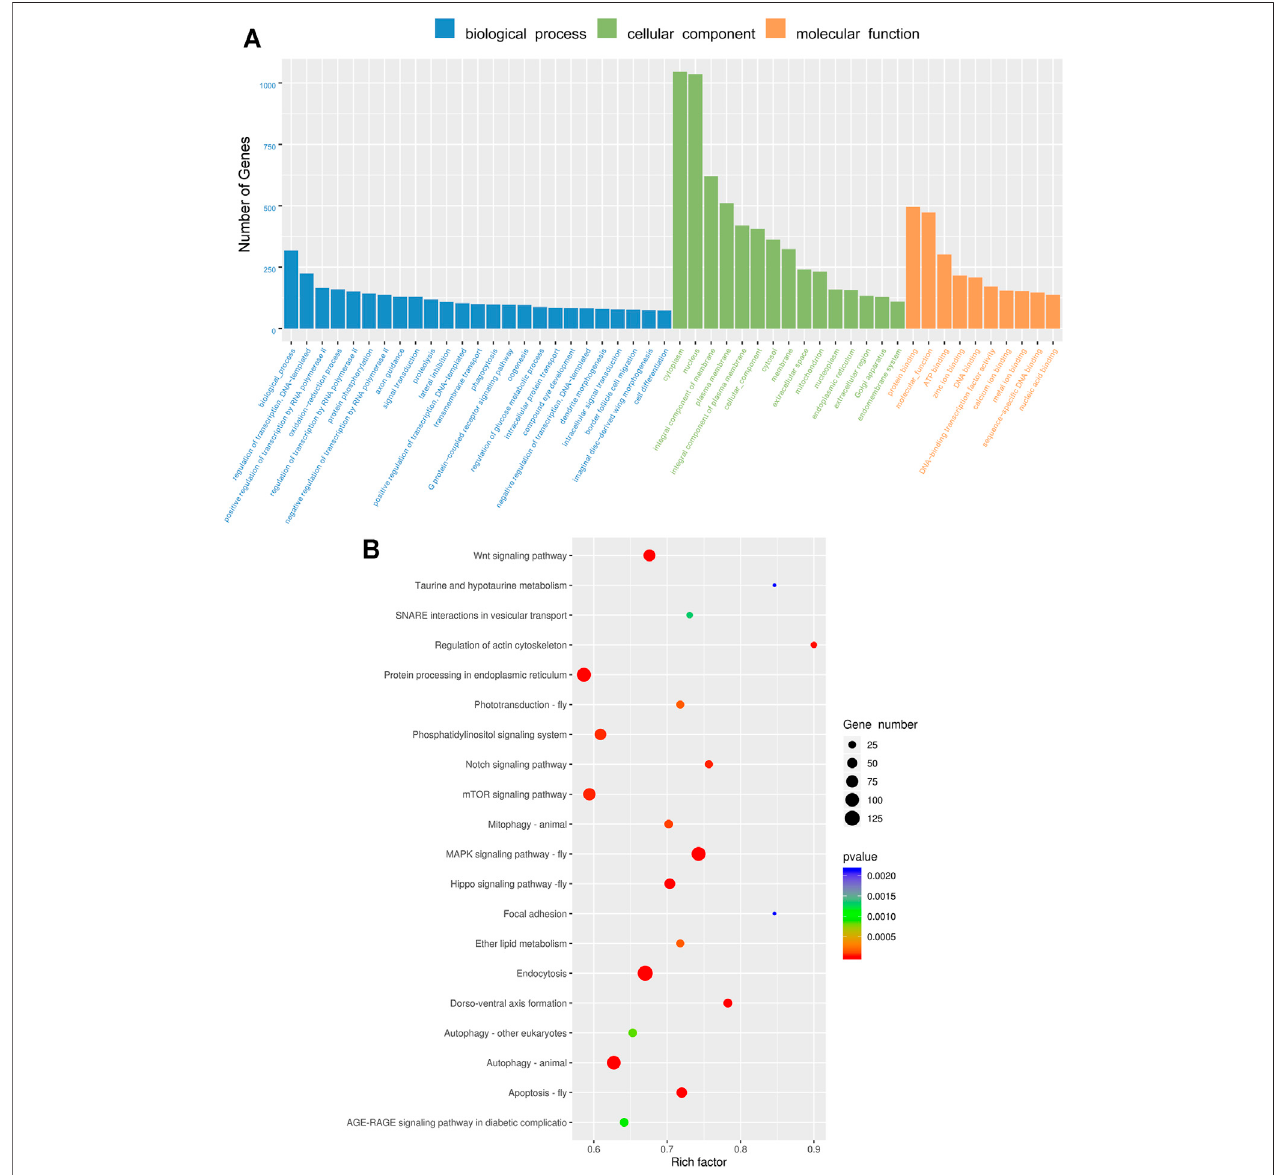
FIGURE 4 | Gene Ontology (GO) term and the Kyoto Encyclopedia of Genes and Genomes (KEGG) pathway of the target genes. (A) Gene Ontology (GO) term of the target genes of differentially expressed miRNAs. (B) Kyoto Encyclopedia of Genes and Genomes (KEGG) pathway enrichment of the target genes of differentially expressed